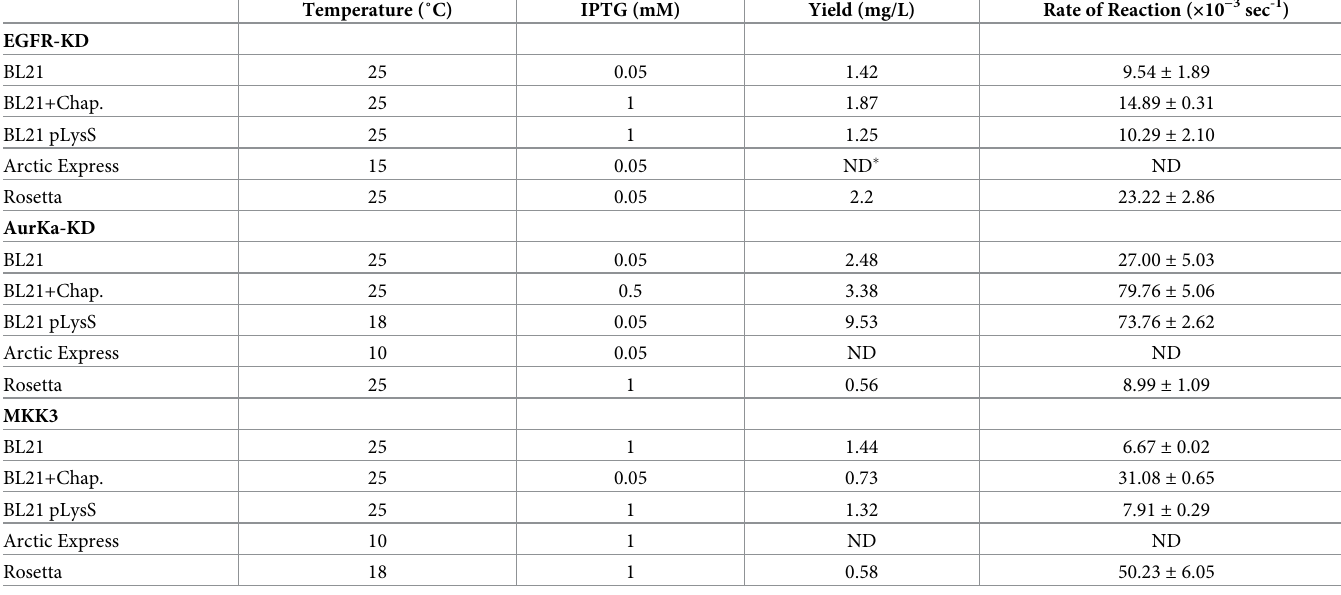
Table 1. The optimized expression conditions, yield, and activity for the expressed kinases in different bacterial strains (all strains showed optimum expression with ON induction time). The reaction rates were calculated as detailed in Material and Methods section and represented in Fig